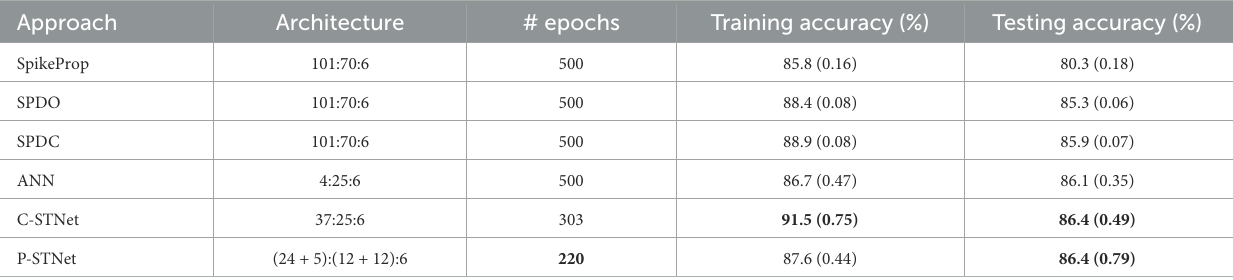
TABLE 6 Results of six approaches on the Statlog Landsat dataset.